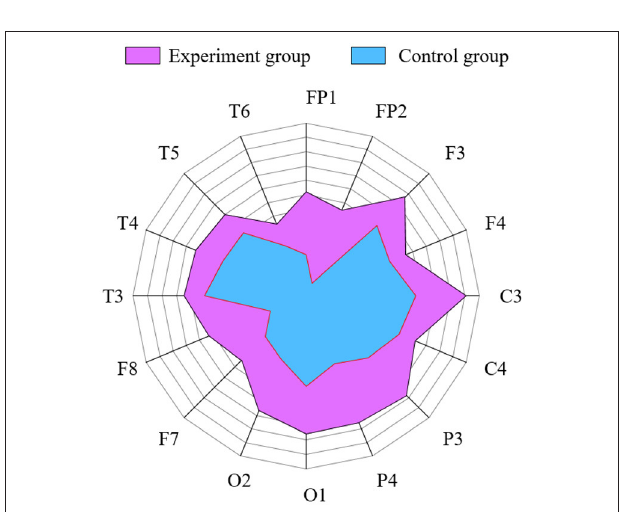
FIGURE 8 | Comparison of WMMSE values between the experimental and control group in each channel. Radius represents WMMSE values.